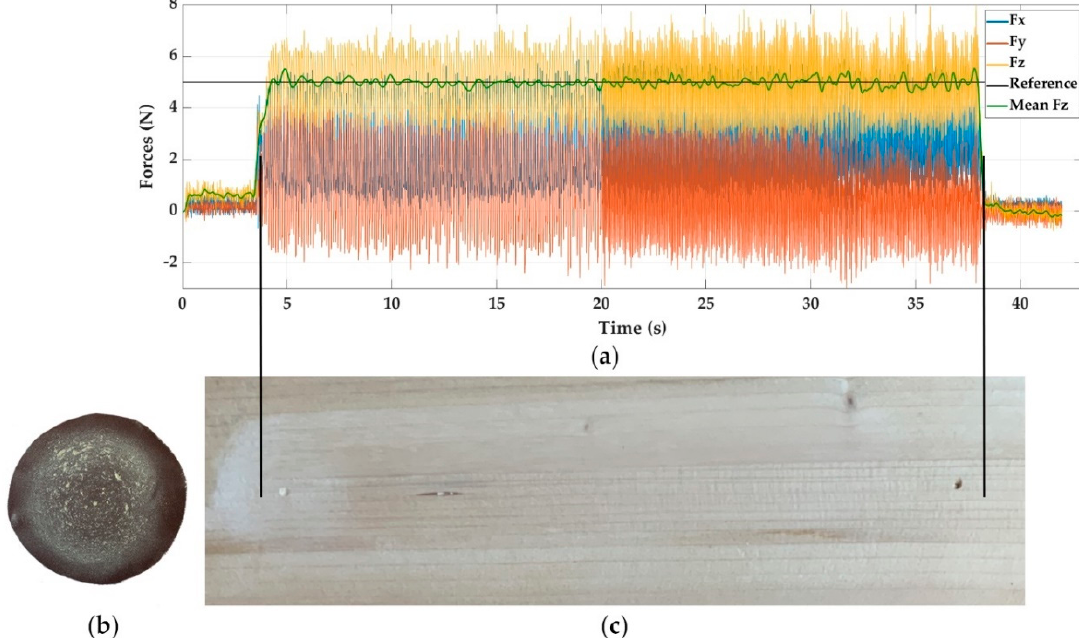
Figure 8. Experiment E14, sanding wood with P+FF control and reference force of 5 N. ( a ) Force response, ( b ) sandpaper aspect, and ( c ) visual surface finish.